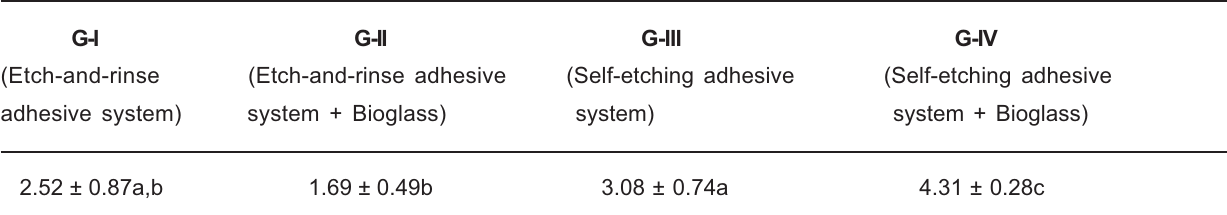
Different letters indicate statistically significant difference at 5% significance level (ANOVA, Tukey’s test).